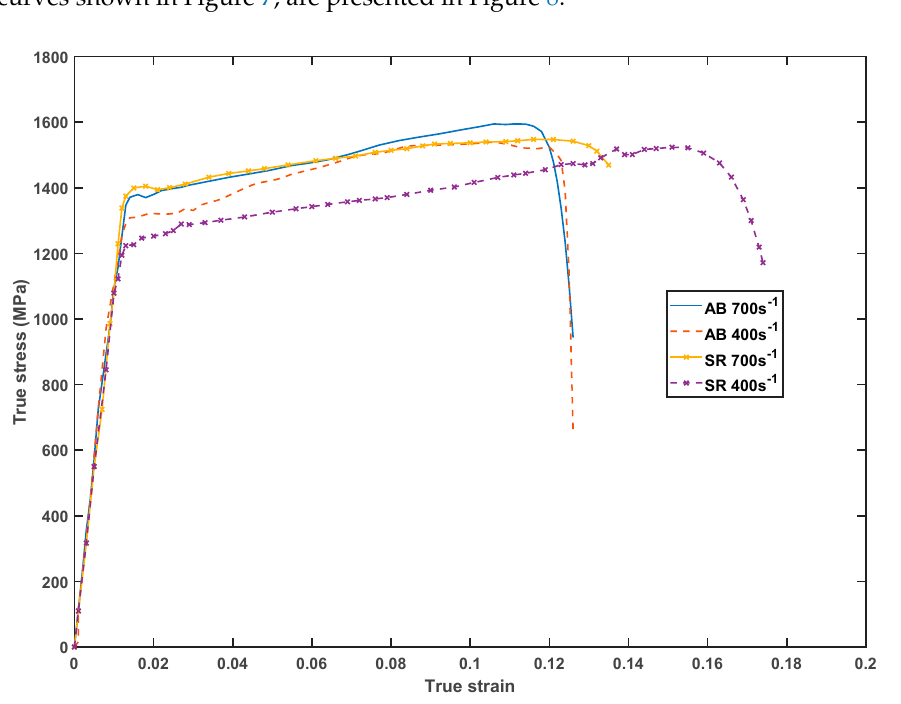
Figure 8. The resultant average compressive true stress–strain curves for the AB and SR samples at two different strain rates.